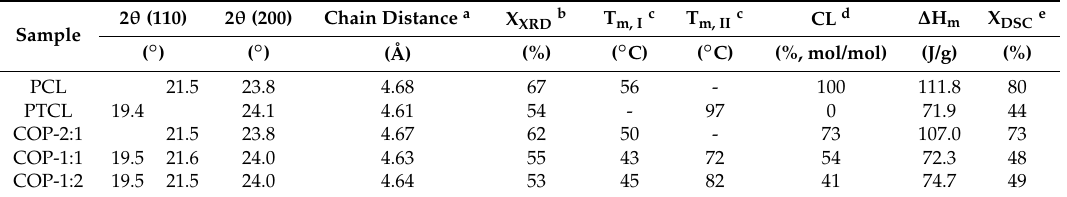
Table 1. Main results from X-Ray diffraction (XRD) and Differential scanning calorimetry